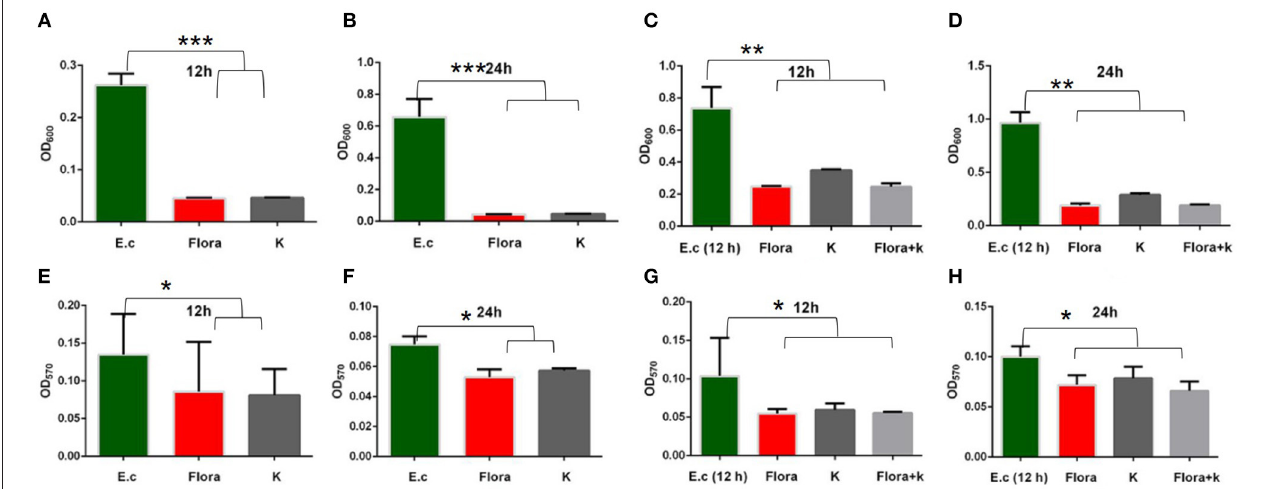
FIGURE 9 | Effects of phages and kanamycin sulfate (10 µ g/ml) on biofilms. (A,B) Effects of phage Flora and kanamycin sulfate (10 µ g/ml) on E. coli (inoculated at a concentration of 4 ‰ ) growth after 12 and 24h of culture (OD 600 ). (E,F) Effects of phage Flora and kanamycin sulfate (10 µ g/ml) on E. coli (inoculated at a concentration of 4 ‰ ) biofilms cultured for 12 and 24h (OD 570 ). (C,D) Effects of phage Flora and kanamycin sulfate (10 µ g/ml) on E. coli (inoculated at a concentration of 4 ‰ ) growth after first being cultured for 12h, followed by phage Flora and kanamycin sulfate (10 µ g/ml) addition and culturing for 12 and 24h (OD 600 ). (G,H) Effects of phage Flora and kanamycin sulfate (10 µ g/ml) on E. coli (inoculated at a concentration of 4 ‰ ) biofilms after first being cultured for 12h, followed by phage Flora and kanamycin sulfate (10 µ g/ml) addition and culturing for 12 and 24h (OD 570 ). * p < 0.05, ** p < 0.01, *** p < 0.001.